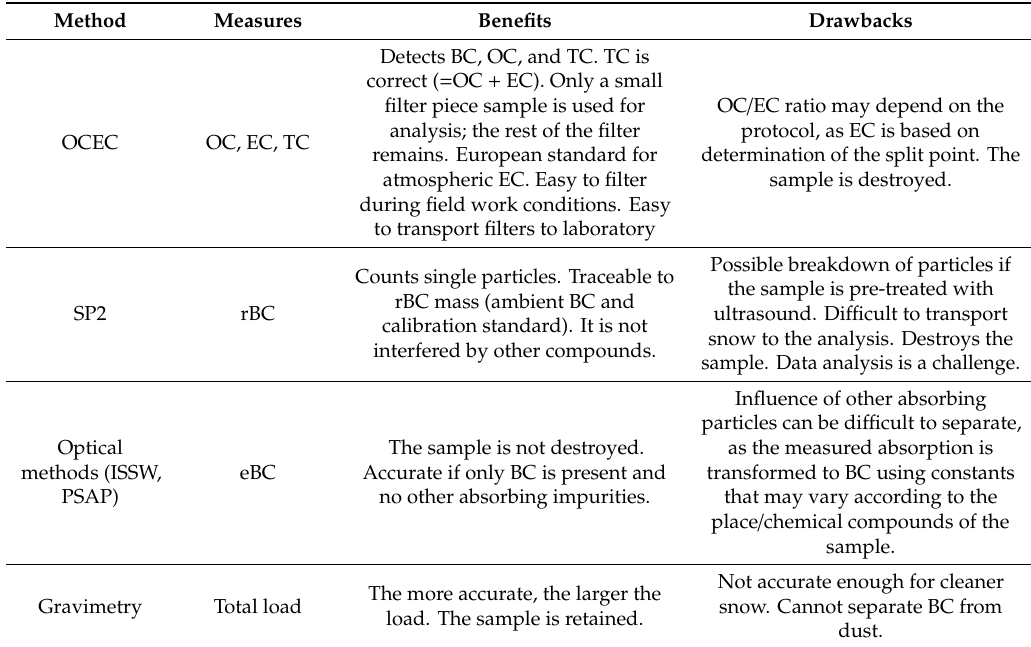
Table 3. Benefits and drawbacks of various methods for studies on black carbon (BC) and organic carbon (OC) in snow, based on our experience of using OCEC, SP2, optical methods, and